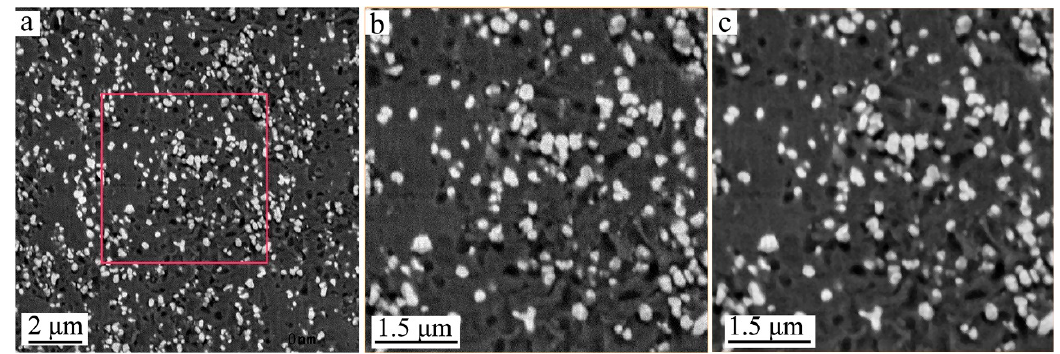
Figure 1. Two-dimensional (2D) backscattered electron (BSE) micrographs of the TiO 2 pigmented waterborne paint film obtained from serial block-face scanning electron microscopy (SBFSEM) measurement: ( a ) An original BSE micrograph slice of the sample acquired by SBFSEM; ( b ) The zoomed-in image of the part enclosed by the red square, 500 × 500 pixels (6.5 µm × 6.5 µm) large, in panel a; ( c ) The noise reduction processed image of the selective part as shown in panel b. The grey parts are acrylic resin, the white parts are TiO 2 particles, and the black parts are voids.